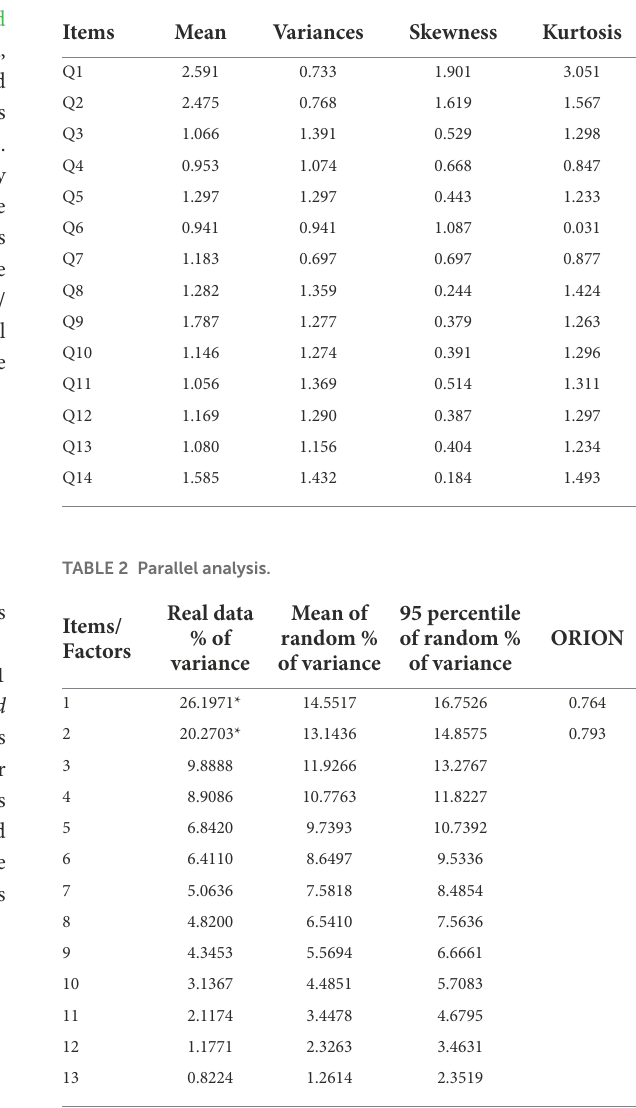
TABLE 1 Mean, variances, skewness and